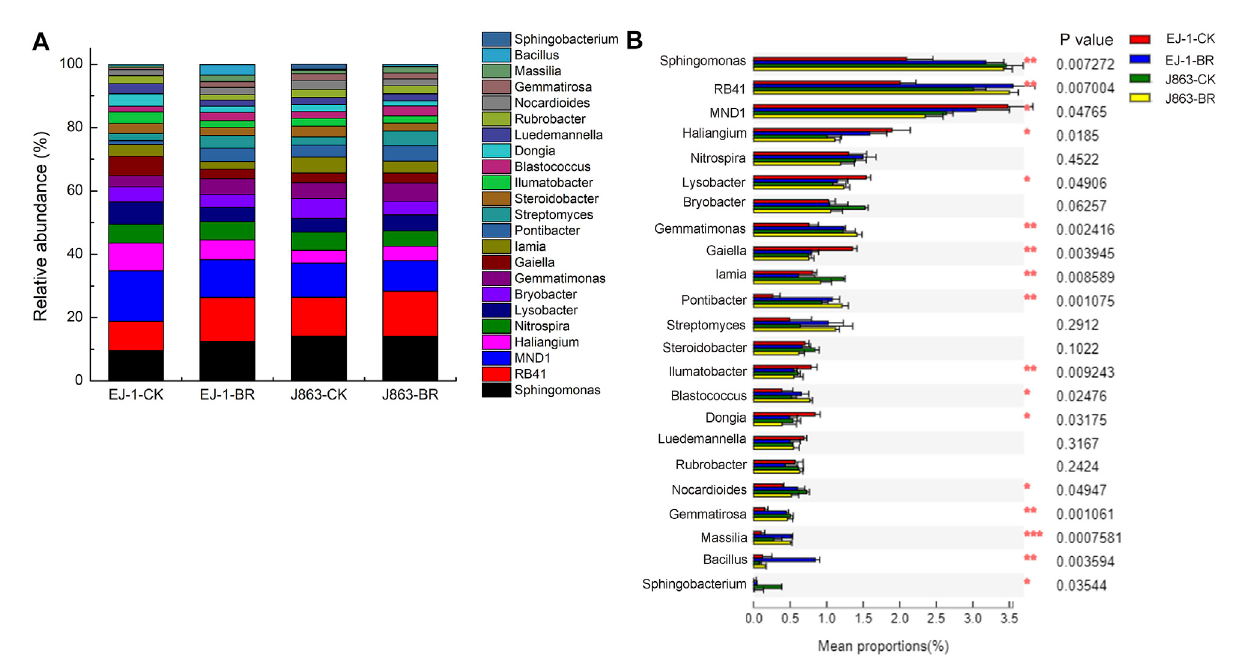
FIGURE 6 Changes in the relative abundances of the bacterial taxa at the genus level under different treatments. (A) Relative abundance of bacterial (B) Analysis of signi fi cant differences in mean proportion of bacterial. CK represents treatment with blank control, BR represents treatment with broccoli residues. EJ-1 represents susceptible cultivar for CVW, J863 represents resistant cultivar for